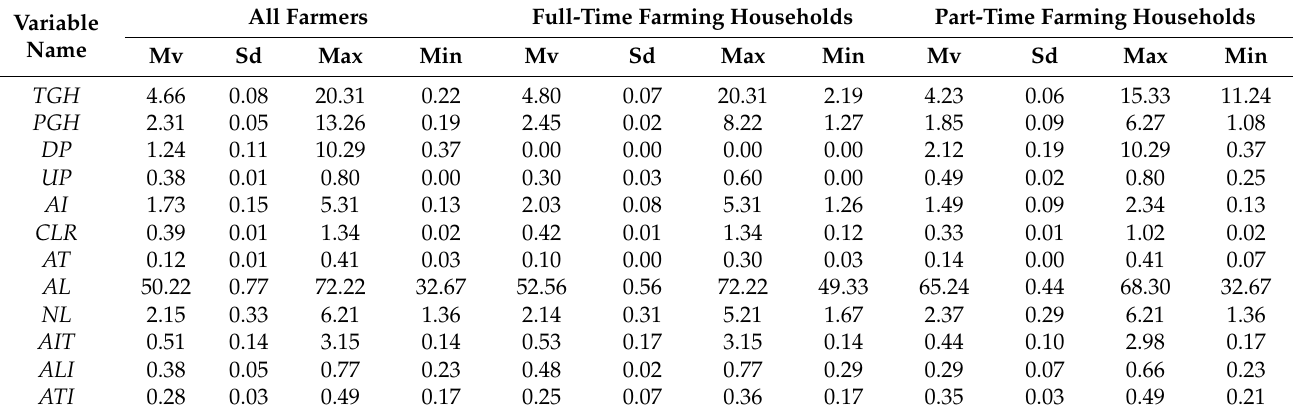
Table 2. Descriptive